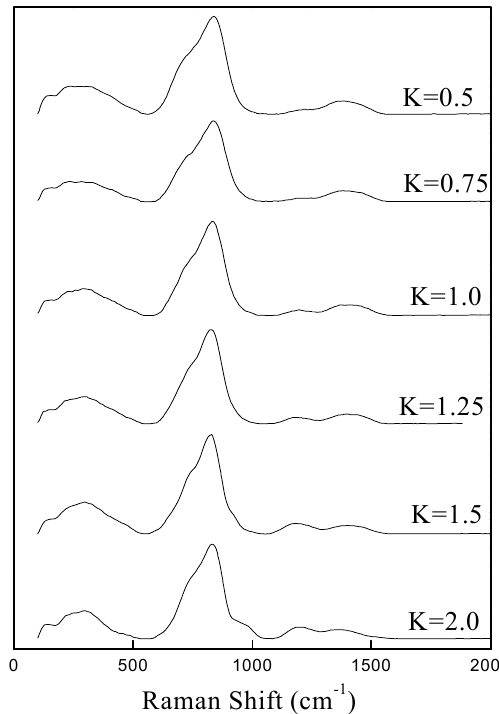
Figure 4. Raman spectra for samples with different